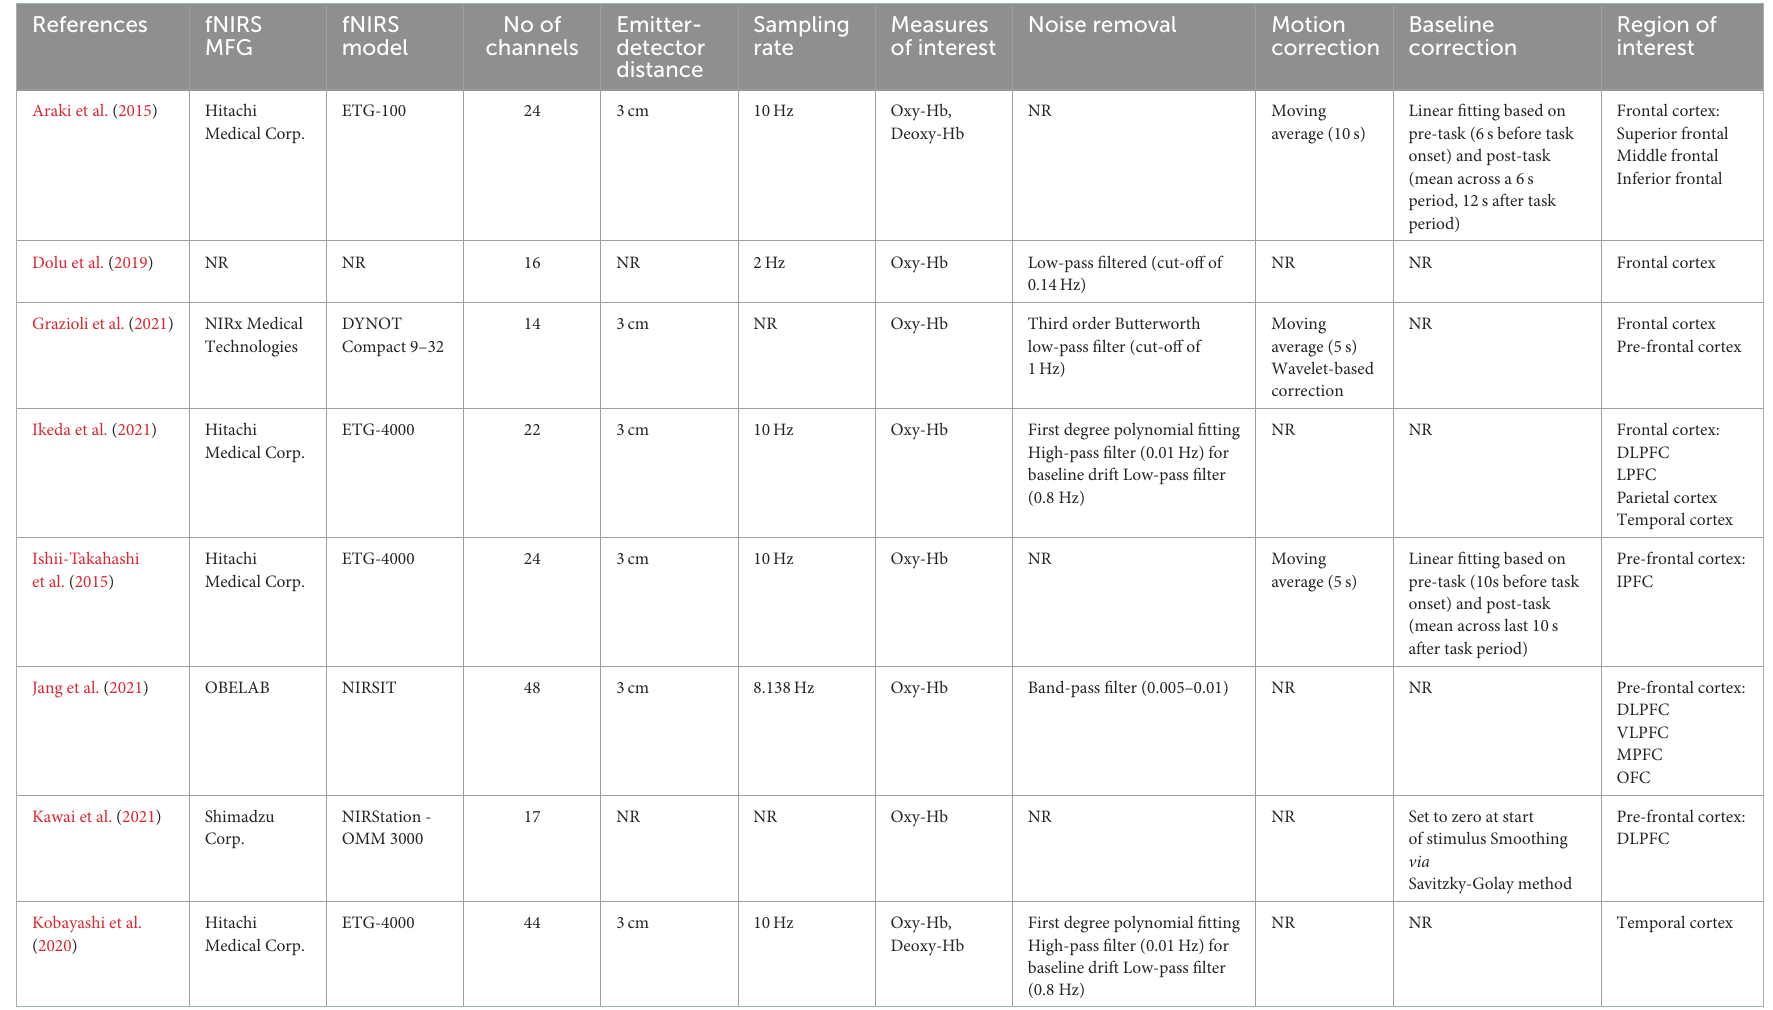
TABLE 3 fNIRS set-up and processing from retrieved